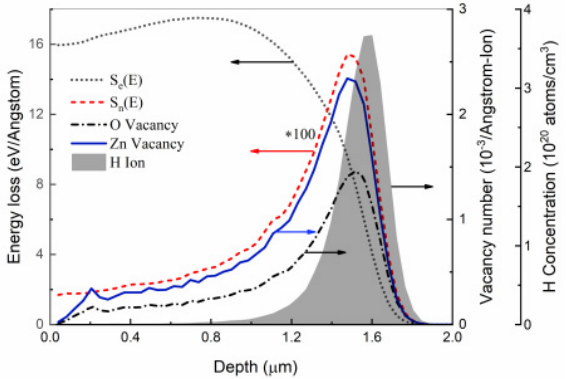
Figure 7. The depth distribution of Se and Sn of H + ions, and V O and V Zn introduced by 180 keV H + ions and rested H + ions calculated with SRIM-TRIM (2013).